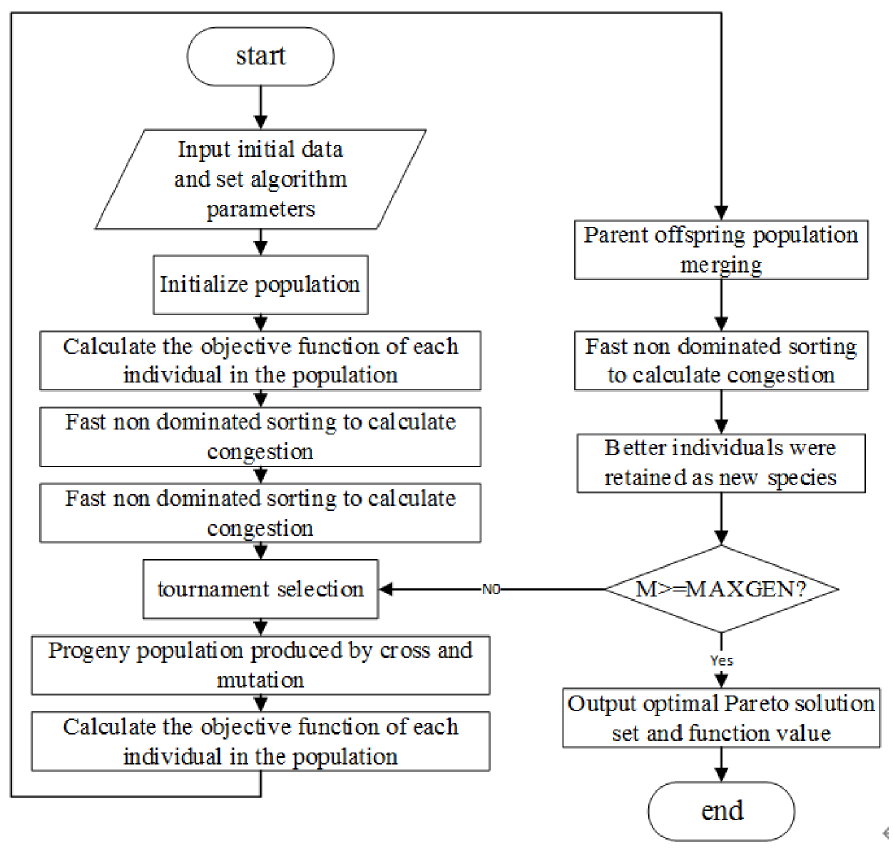
Fig 1. Flow chart of multi objective optimization algorithm based on